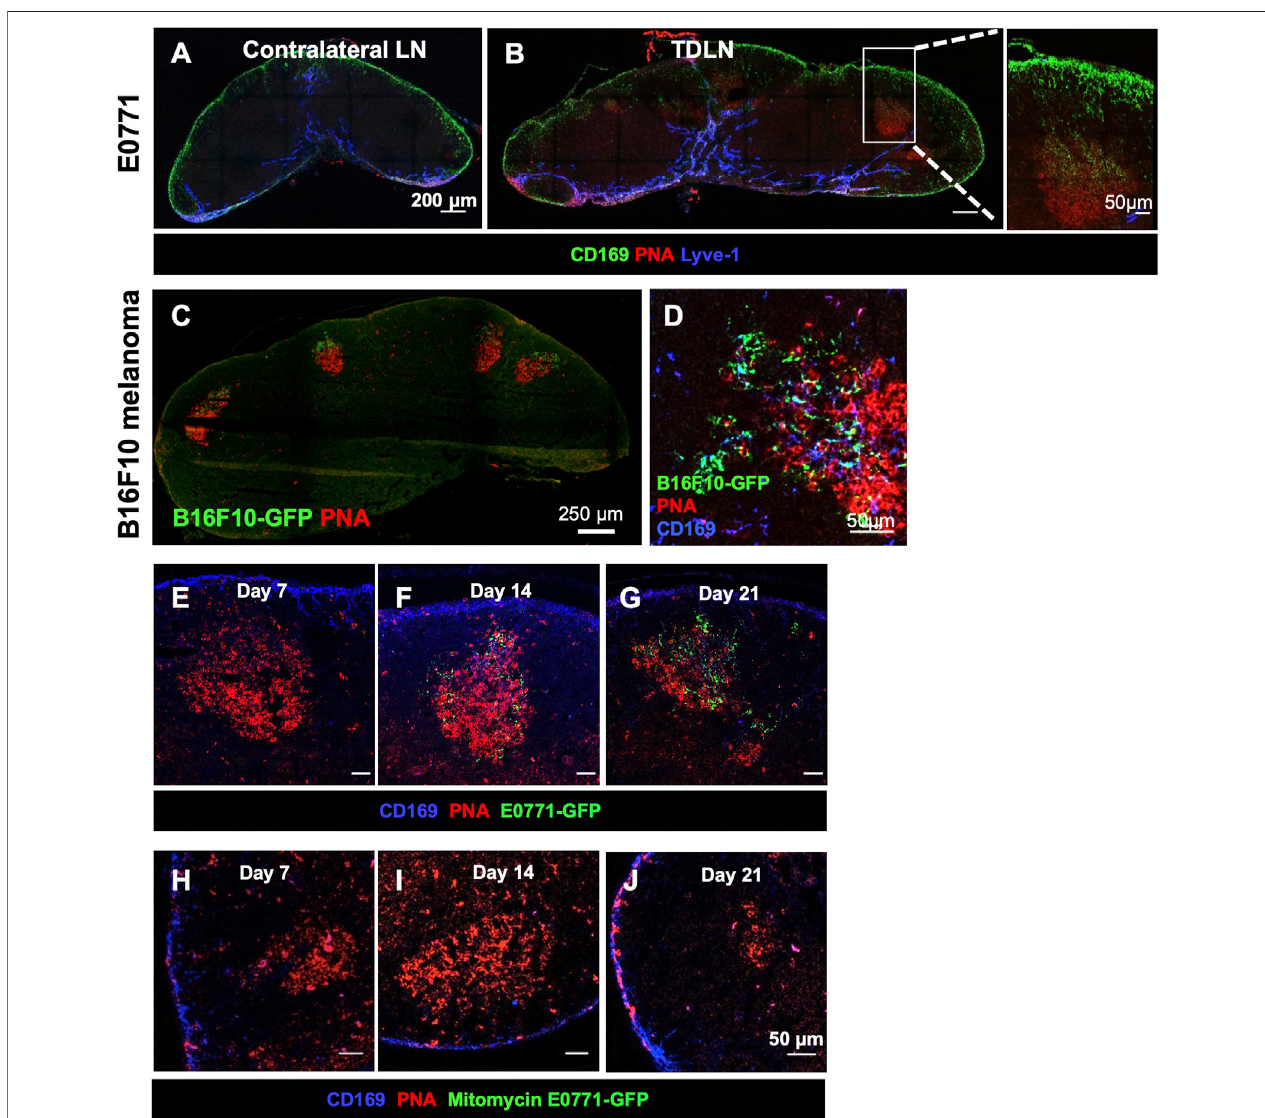
FIGURE 2 | Tumor-associated antigen accumulation depends on a growing tumor. (A,B) GC formation and SCS macrophage colocalization occurs in E0771 TDLN.Imagesarerepresentativeof n =5pergroup,intwoseparatedstudies. (C,D) B16F10-GFPmelanomashowtumor-associatedantigen(GFP)accumulationinthe GCswithCD169 + SCSmacrophageintheTDLNs. n =5. (E – G) GCandGFPintheTDLNatdifferenttimepointspost-E0771-GFPimplantation. (H – J) GCandGFPinthe LN when injected with 10 7 mitomycin-treated E0771-GFP cells. IF images are a representative of n = 5 per group, in two separated